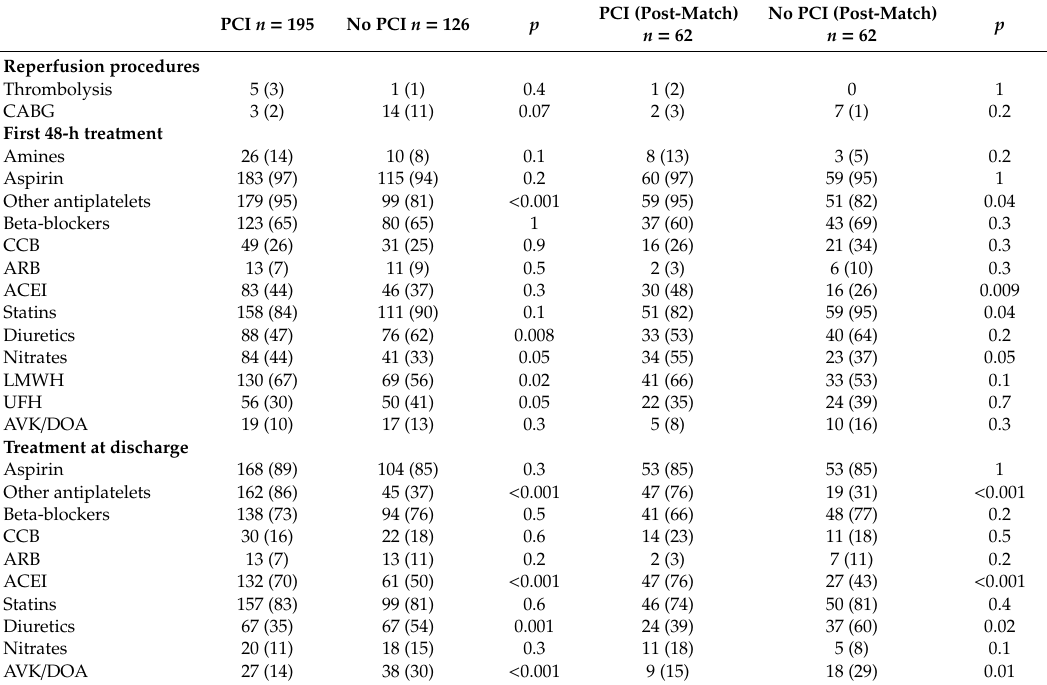
Table 2. Acute management ( n (%)).